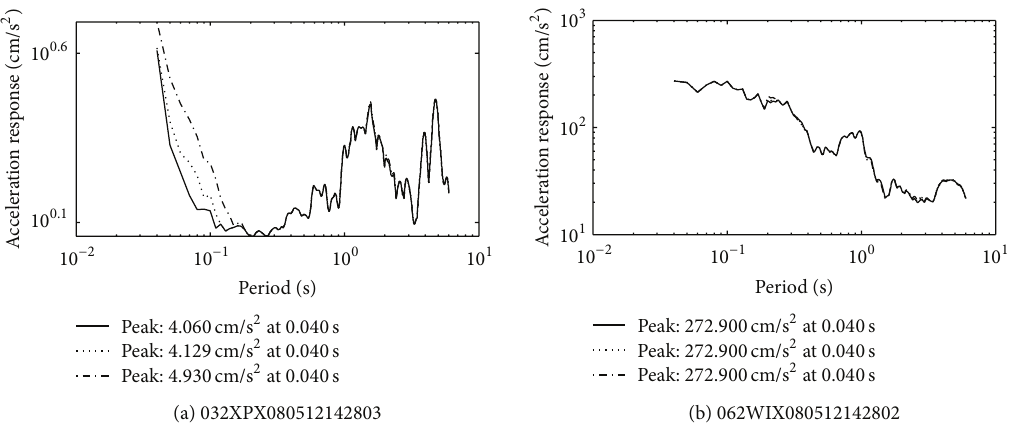
Figure 11: Spikes effect on the time history, the acceleration Fourier amplitude spectrum, and the absolute acceleration response spectrum.